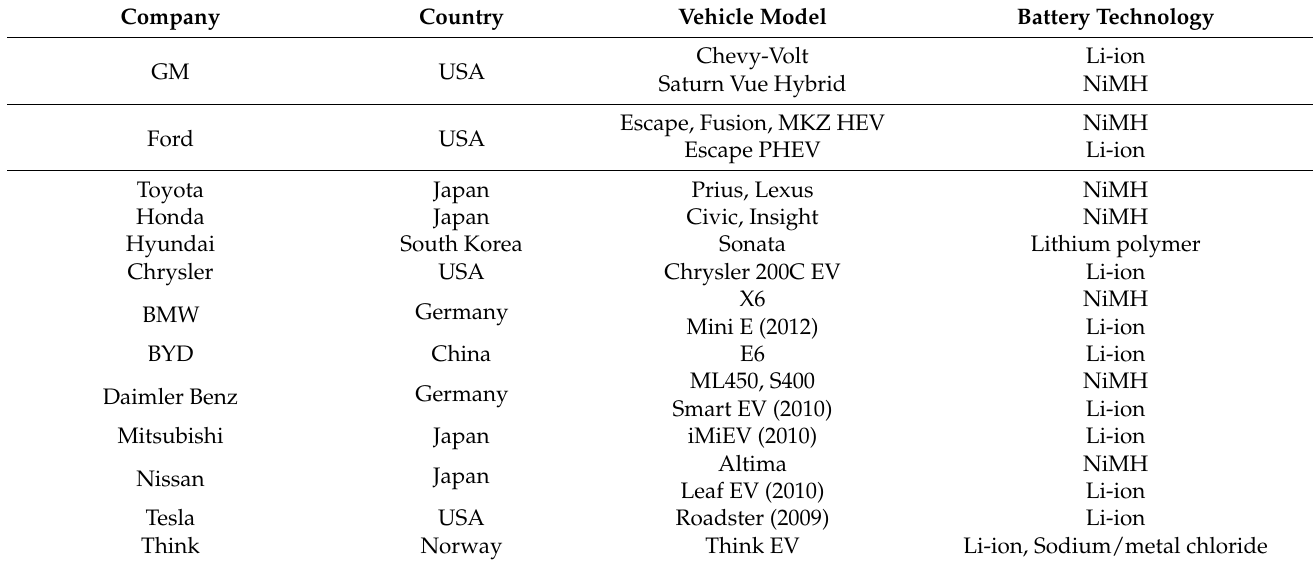
Table 1. Electric vehicle batteries used by car manufacturers